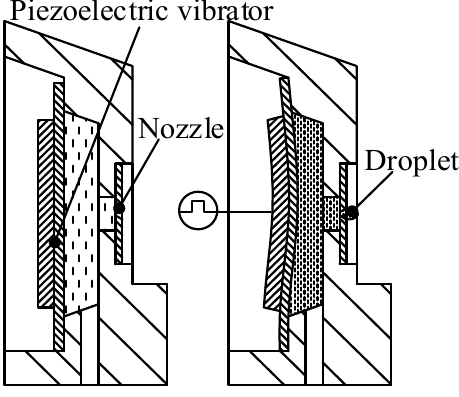
Figure 1. The structure of the micro-jet.